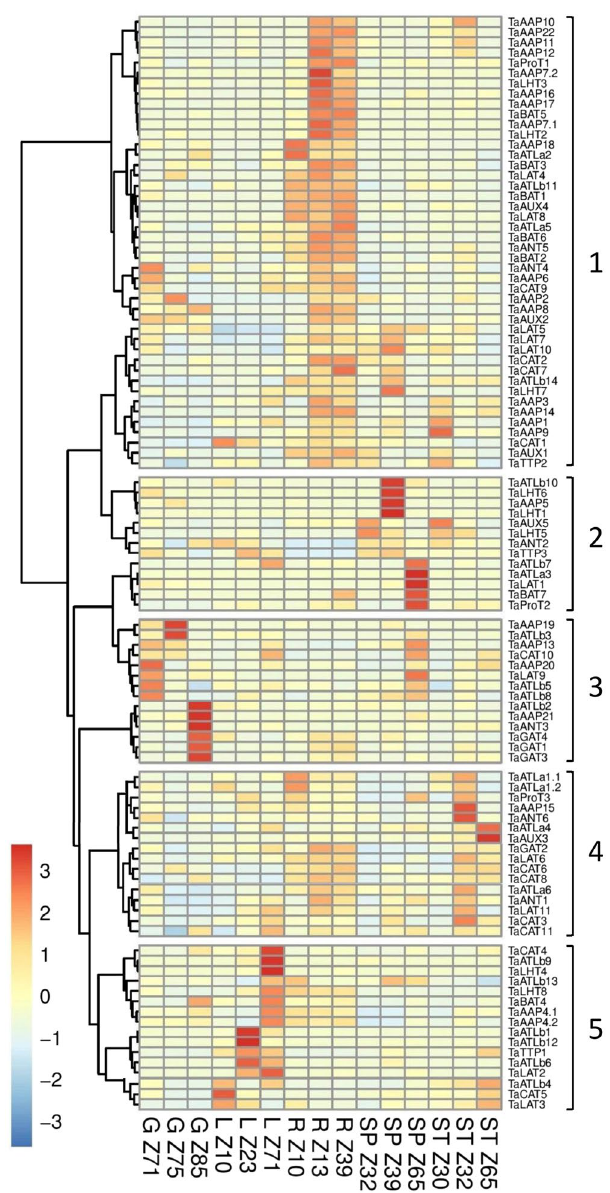
Figure 3. Spatiotemporal expression patterns of AAPs in different wheat organs scaled by row for Grain (G), Leaf (L), Root (R), Spike (SP), Stem (ST). The developmental stages are shown as Zadoks: Z10 (seedling stage), Z13 (three leaf stage), Z23 (tillering stage), Z30 (1 cm spike), Z32 (two nodes detectable), Z39 (flag leaf stage), Z65 (anthesis), Z71 (2 DPA, days post anthesis), Z75 (14 DPA), Z85 (30